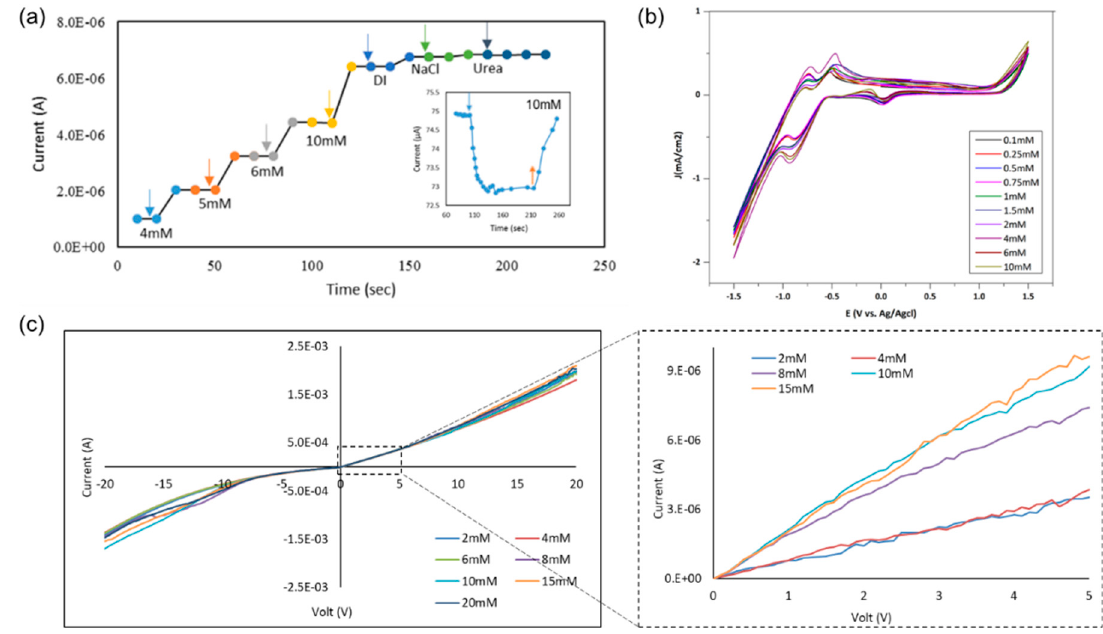
Figure 4. ( a ) Testing 4–10 mM of glucose on G/30 nm PtO/n-Si; ( b ) cyclic voltammetry of different glucose concentrations (0.1–10 mM) using a G/30 nm PtO; ( c ) I–V characteristics of the presence of different glucose concentrations from 2 to 20 mM at a sweep voltage from − 20 to 20 V.